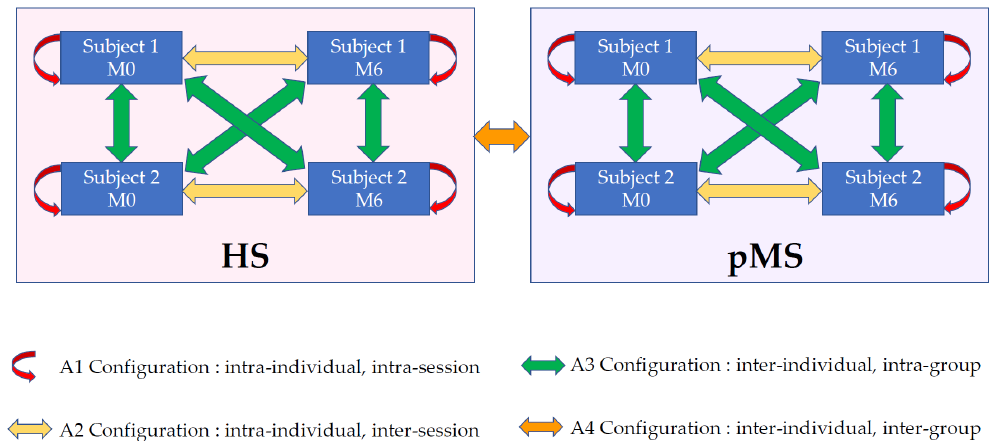
Figure 3. Definitions of the different pairs of extraction/detection trials that are analyzed in the